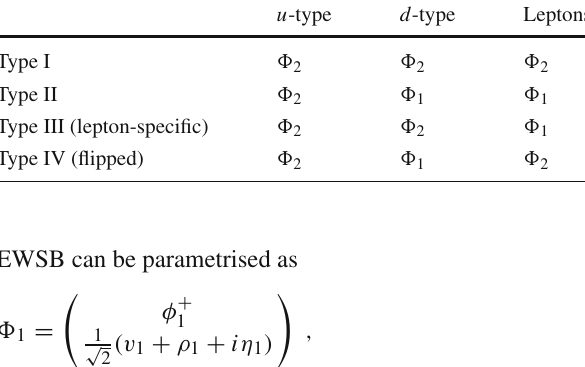
Table 1 Allowed fermion couplings in the four types of N2HDM u -type d -type